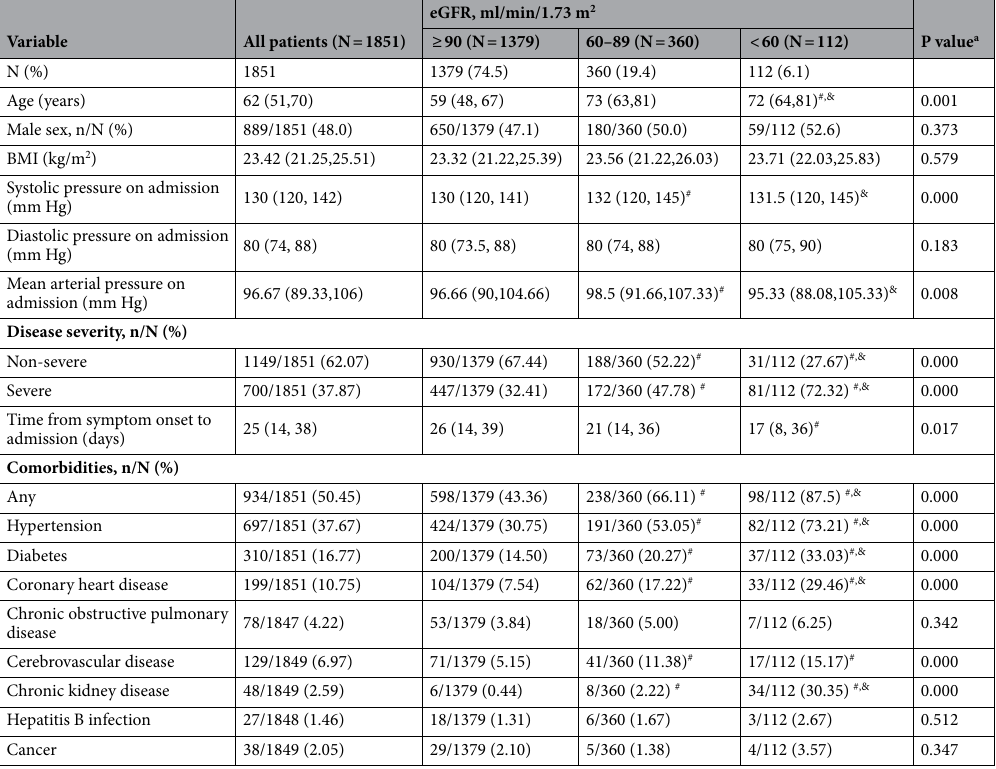
Table 1. Clinical characteristics of COVID-19 patients stratified by eGFR levels. Data are expressed as median (interquartile range) or no./total no. (%). a P values were calculated using the Kruskal–Wallis test or the chi- square test. COVID-19, coronavirus disease 2019; eGFR, estimated glomerular filtration rate; BMI, body mass index. # vs GFR ≥ 90 & vs 60 ≤ GFR <